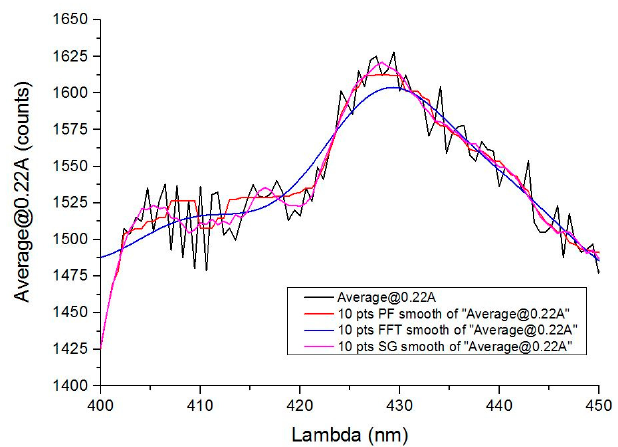
Figure 3. Comparison of the three types of filtering carried out with all the samples: the figure shows a detail of the measurement at 220 mA with a sample of gasoline 95. MF: median filtering. FFT: fast fourier transform. SG: Savitzky-Golay filtering. Note that SG filtering eliminates noise without compromising maximums and minimums.